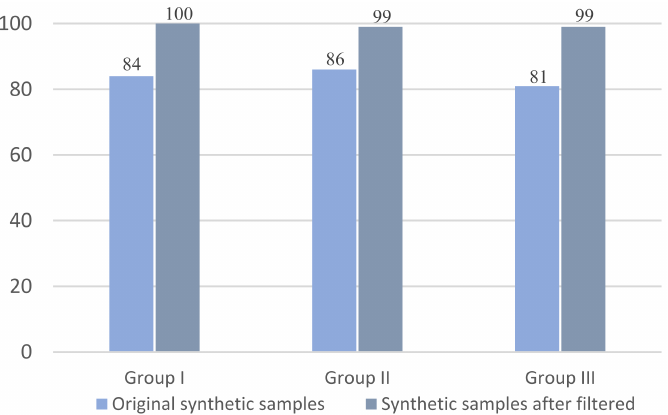
Figure 7. The numbers of reasonable samples in the synthetic